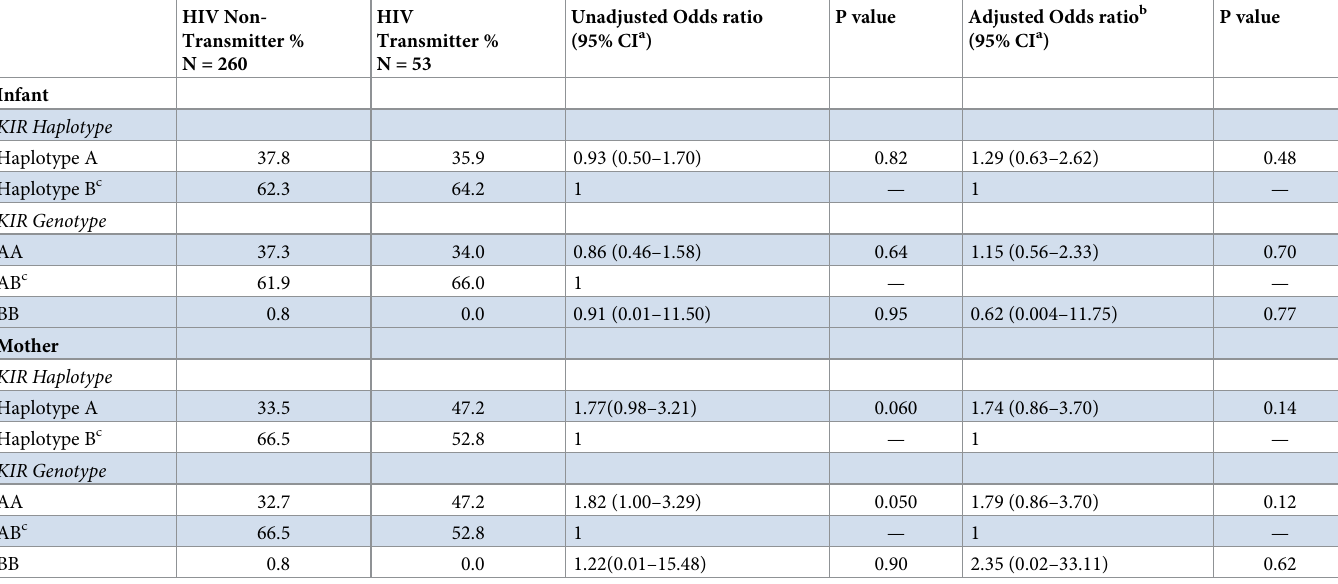
Table 3. Relationship of KIR haplotypes and genotypes with perinatal transmission of HIV-1. HIV Non- Transmitter